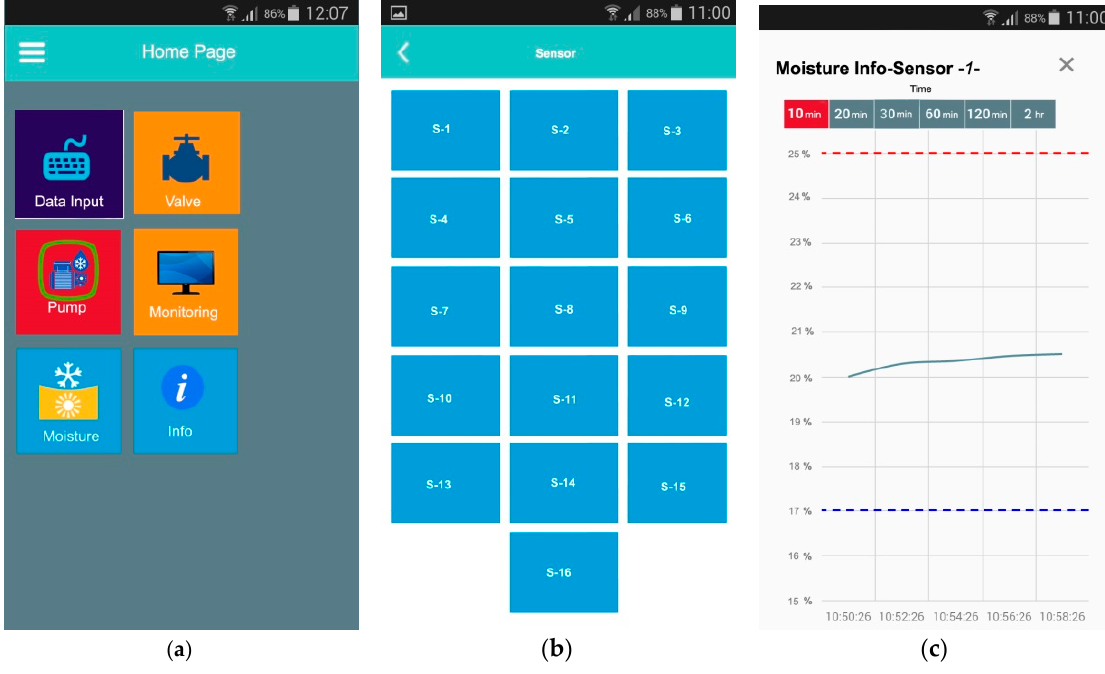
Figure 9. Smart phone monitoring page. ( a ) Home screen, ( b ) Sensor Menu, ( c ) Sensor 1’ e moisture value.